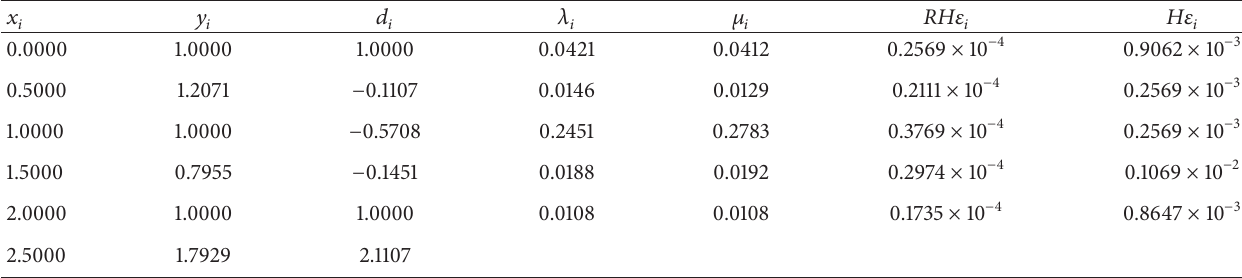
Table 1: The parameters 𝜆 𝑖 and 𝜇 𝑖 for EH interpolation spline and the max